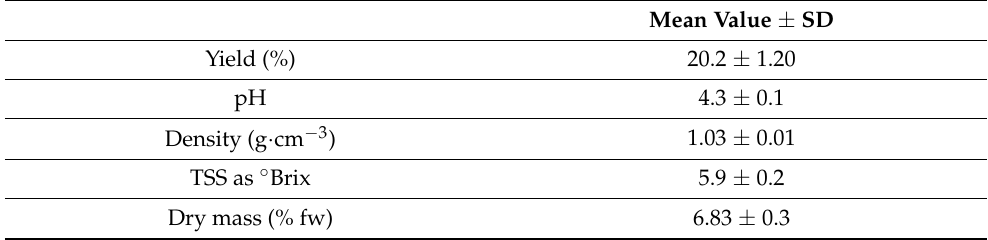
Table 1. Yield and physical-chemical properties of cladodes